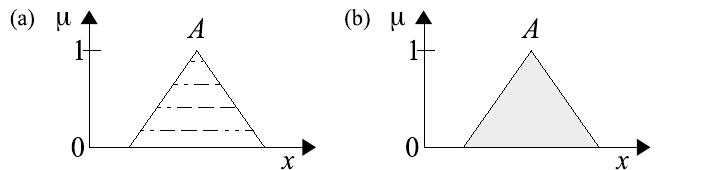
Figure 8. “Horizontal” way of defining a T1FS A as the sum of a finite α -cuts ( a ) and an infinite number ( b ) of α -cuts A α .